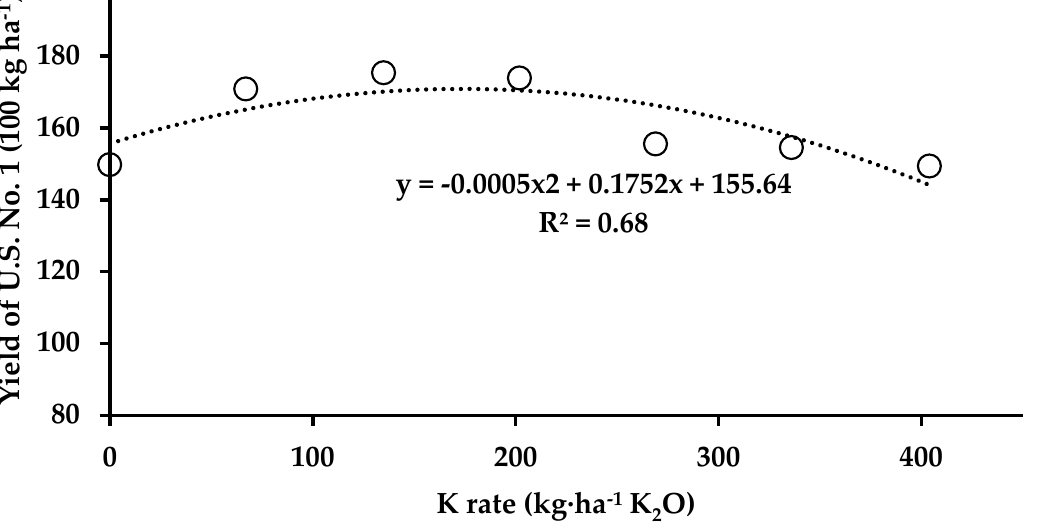
Figure 2. Changes in U.S. No. 1 [20] yield in response to potassium (K) application rate. Each growing season (2018-2021), seven K rates, 67 kg · ha − 1 K 2 O (K67), 135 kg · ha − 1 K 2 O (K135), 202 kg · ha − 1 K 2 O (K202), 269 kg · ha − 1 K 2 O (K269), 336 kg · ha − 1 K 2 O (K336), and 404 kg · ha − 1 K 2 O (K404) in the form of muriate of potash or KCl (0-0-60), as well as an untreated control (CON), were applied before planting. Rate to maximum yield = 174 kg · ha − 1 K 2 O.